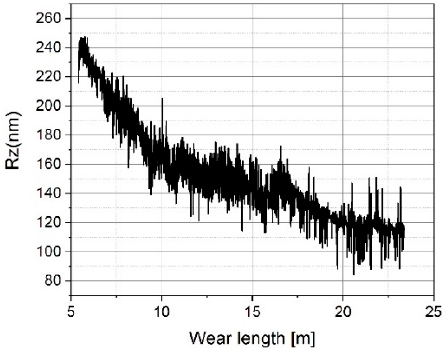
Figure 26. Measured Rz values on the tip-testing standard versus measurement length.